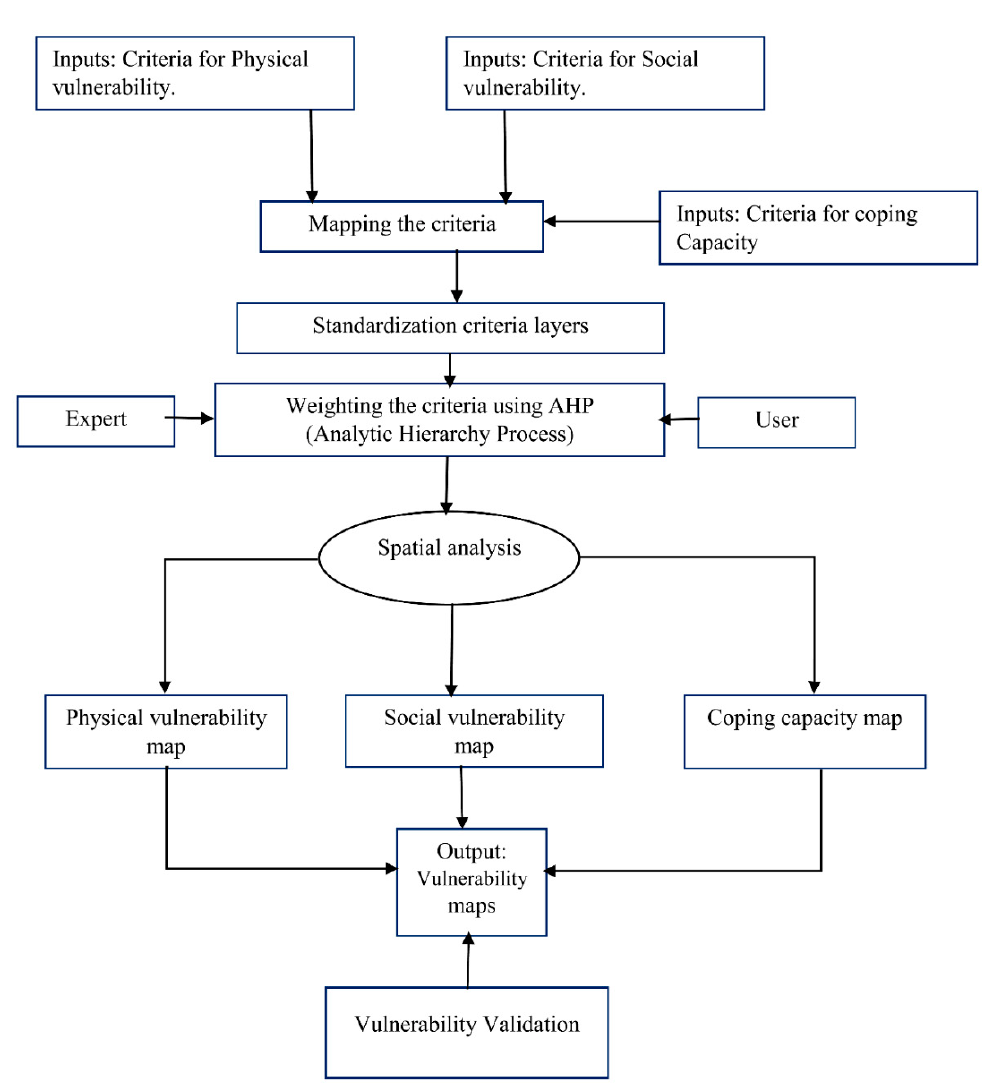
Figure 2. Methodological flowchart of the vulnerability assessment approach followed in this study.